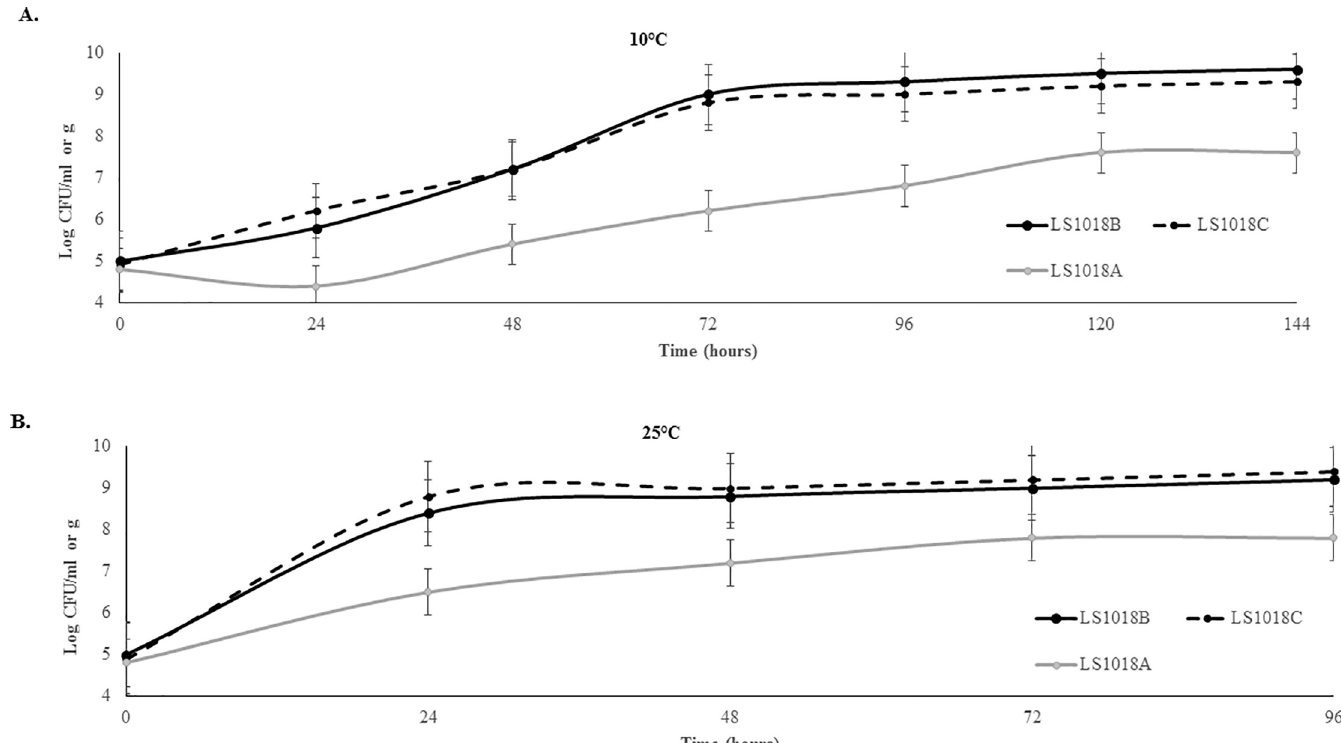
Fig 1. Growth of L . monocytogenes LS1018 in BHI, on cantaloupe or on apple fragments at 10˚C and 25˚C. Results are from two independent experiments; error bars represent a mean ±